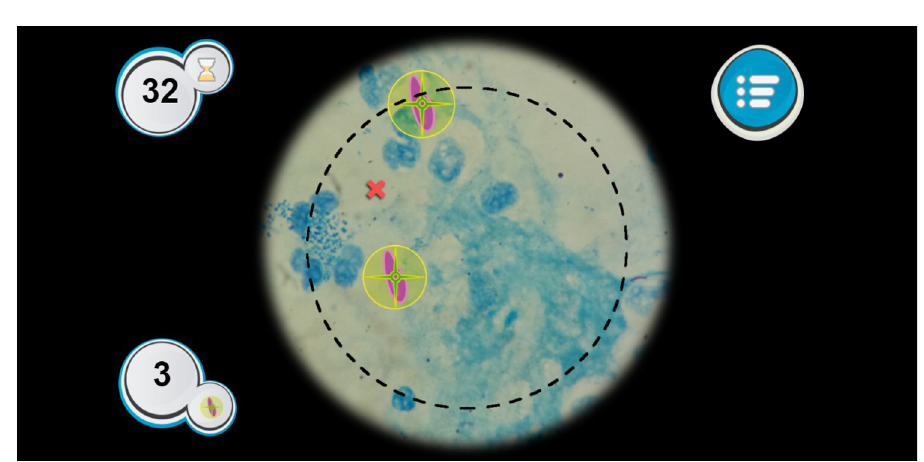
Fig 1. Screenshot of a “known sample” of TuberSpot game. In this sample the number of AFB is known, 36 in this case, and the players have to click in the places where bacilli are believed to be. This kind of samples are used to train the